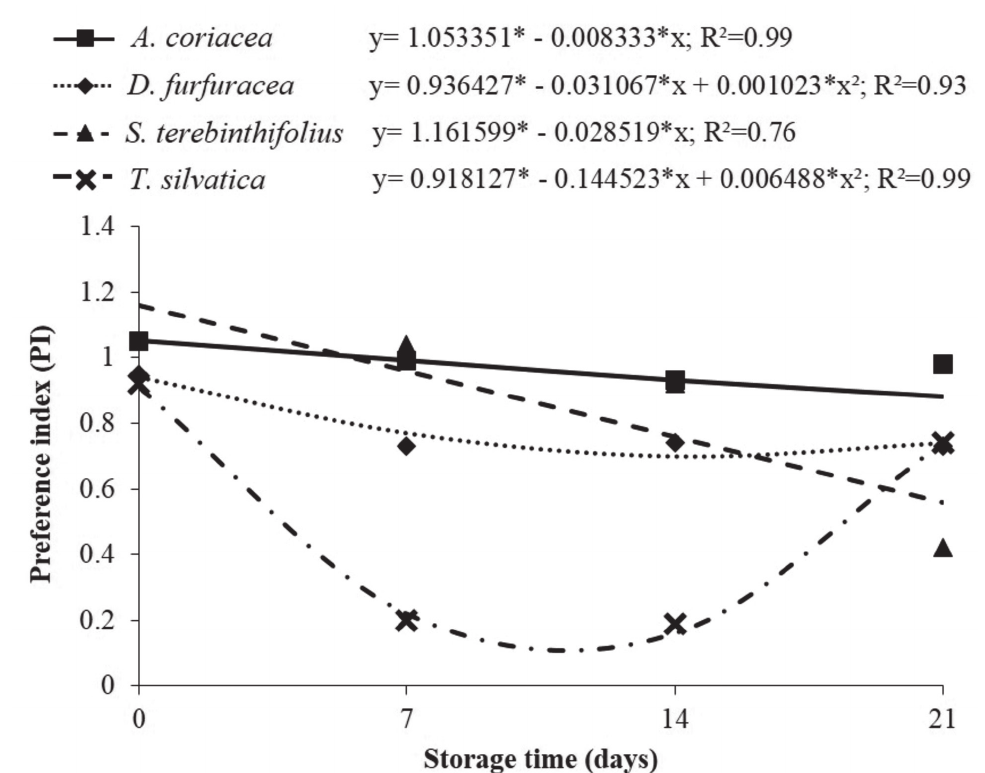
Figure 1 - Preference index (PI) of Plutella xylostella with regard to plant extract and storage period of each extract at a temperature of 25 ± 1°C, relative humidity of 55 ± 5% with a photoperiod of 12 h. Dourados-MS. (*significance level at 5% probability).